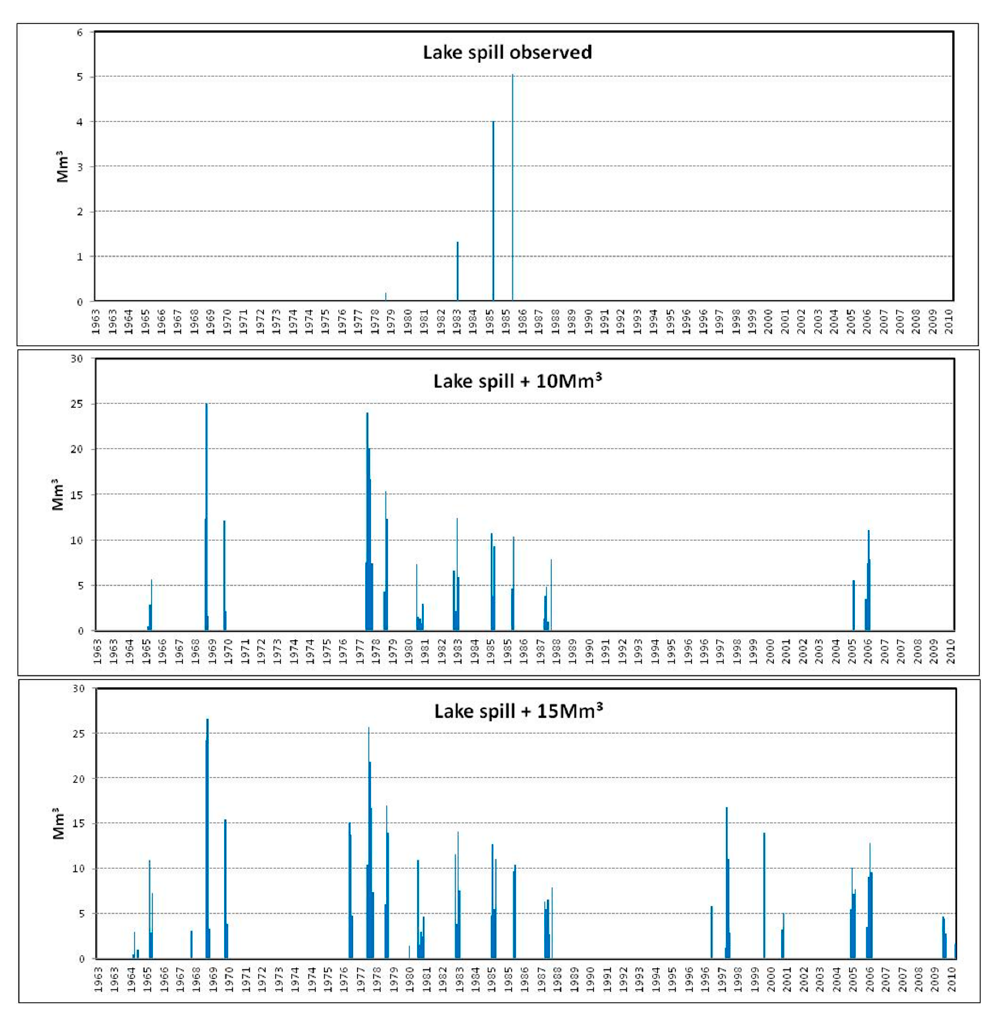
Figure 11. Lake Trasimeno water spill frequency. Water 2016 , 8 , 570